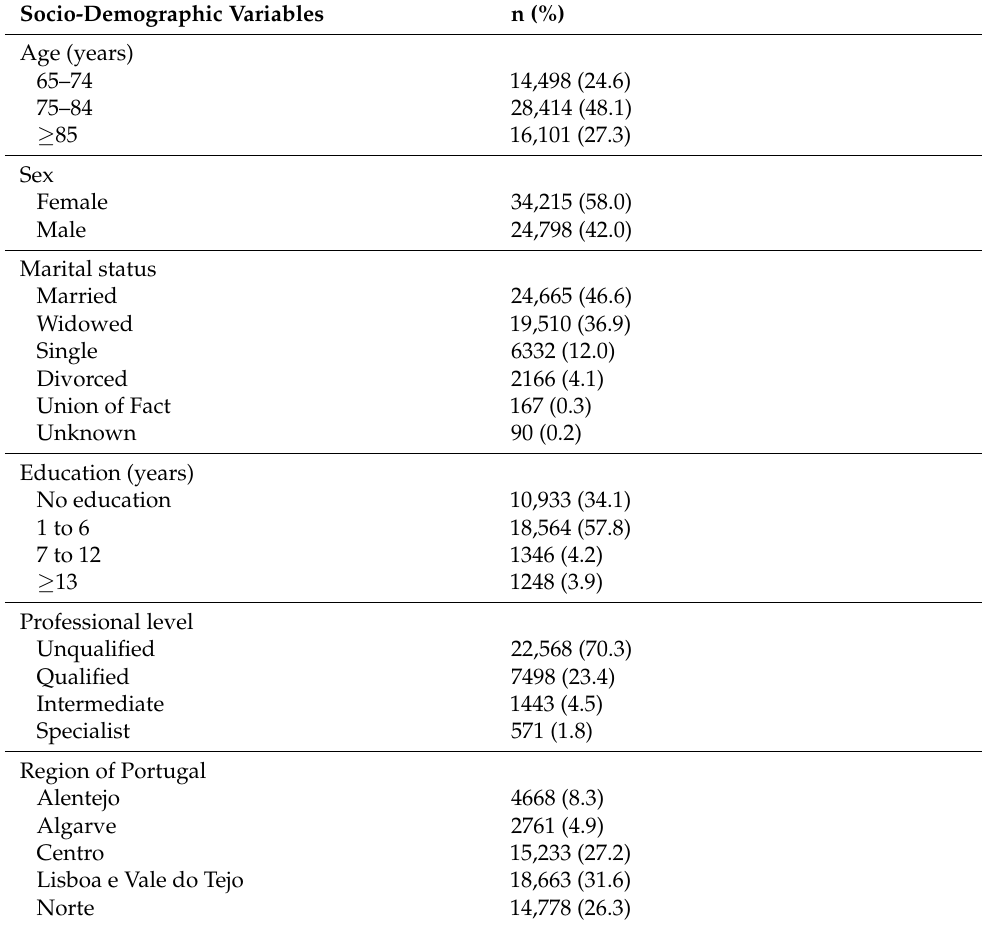
Table 1. Socio-demographic characterization of the study